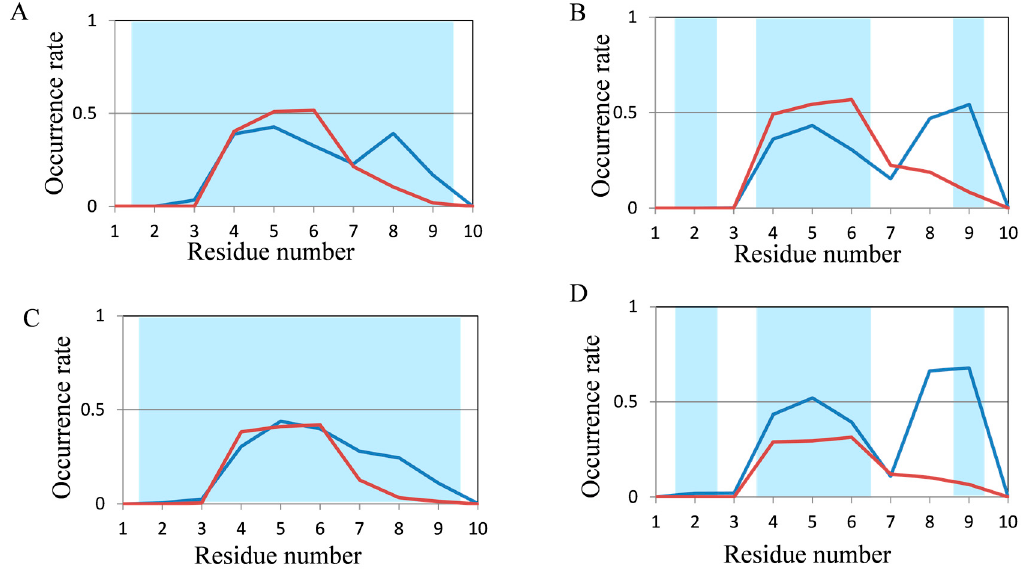
Figure 3. Analysis of the secondary structure formation in chignolin and CLN025 (10 residues) by normal MD simulations. The occurrence rate of secondary structures of ( A ) chignolin; and ( B ) CLN025 in 200-ns simulations and ( C ) chignolin; ( D ) CLN025 in 2000-ns simulations. Red and blue lines show the occurrence rate of helix and β structures in MD simulations, respectively. The background of the graph area for the residues forming helix and β structures in the experimental structures are colored in light red and light blue, respectively.